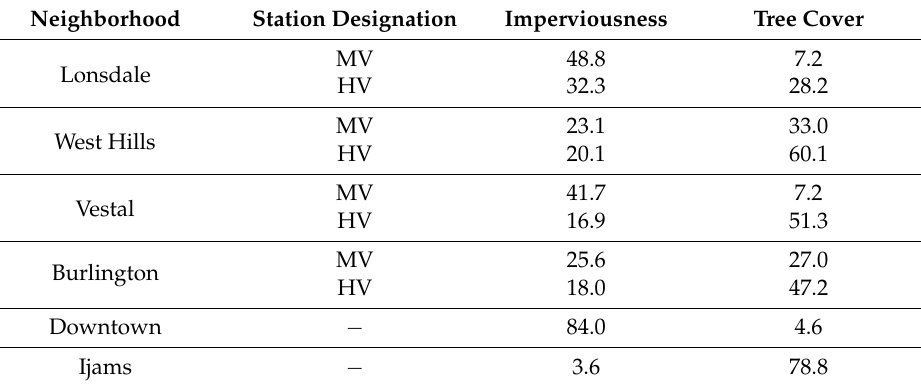
Table 3. Percent impervious land cover and tree cover within a 100-m radius of each station. Neighborhood Station